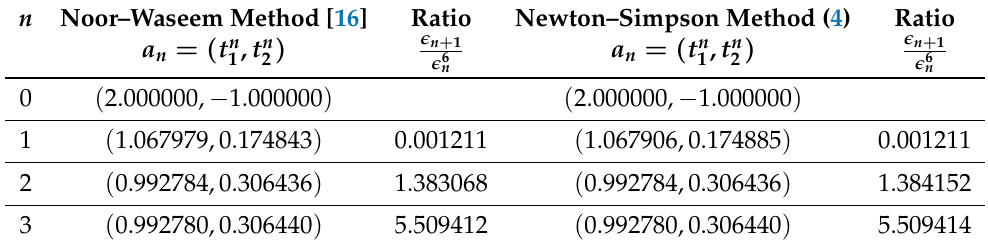
Table 3. Method—Order